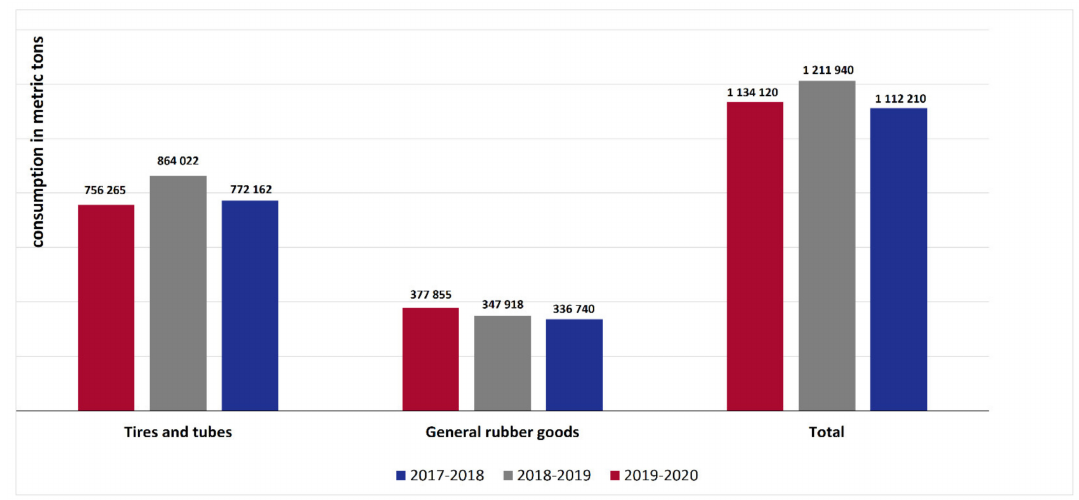
Figure 2. Consumption of natural rubber. Source: statista.com, 27 May 2021.